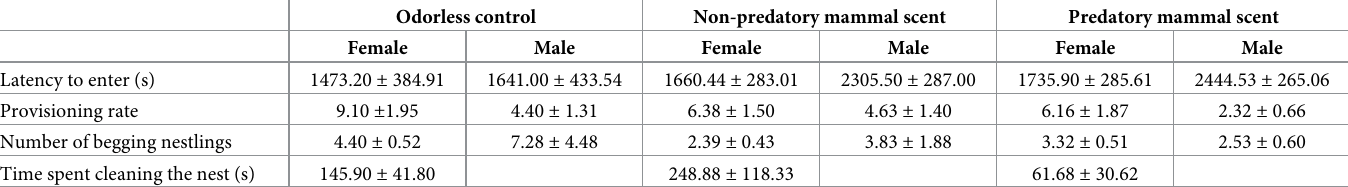
Table 1. Mean ± SE latency to enter the nest-box for the first time, provisioning rate, number of begging nestlings for male and female blue tits, and time devoted to nest sanitation activities by females in relation to experimental treatments: Water (odorless control), non-predatory mammal scent (odorous control) and preda- tory mammal